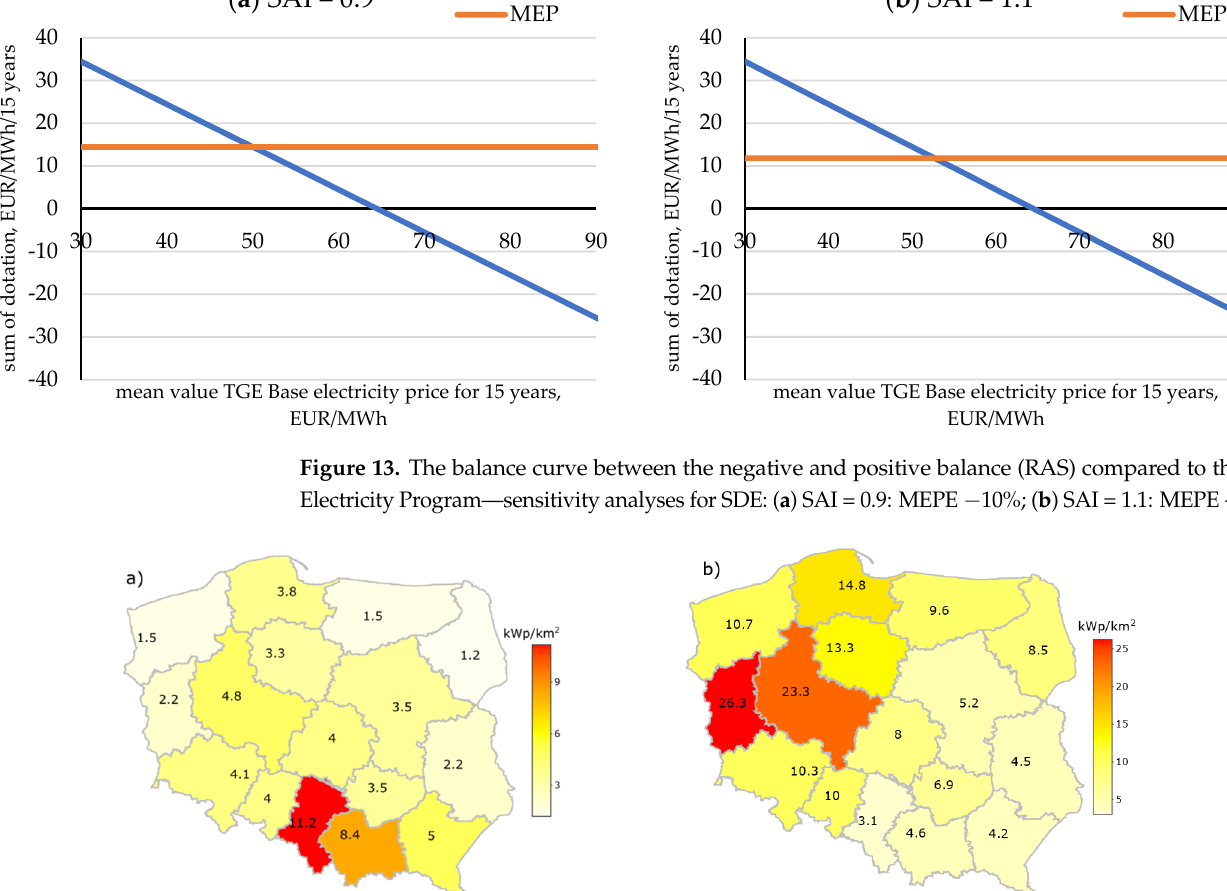
Figure 14. Concentration of PV installation capacity (PIP, kWp/km 2 ) presented by provinces: ( a ) My Electricity Program; ( b ) RES auction system.